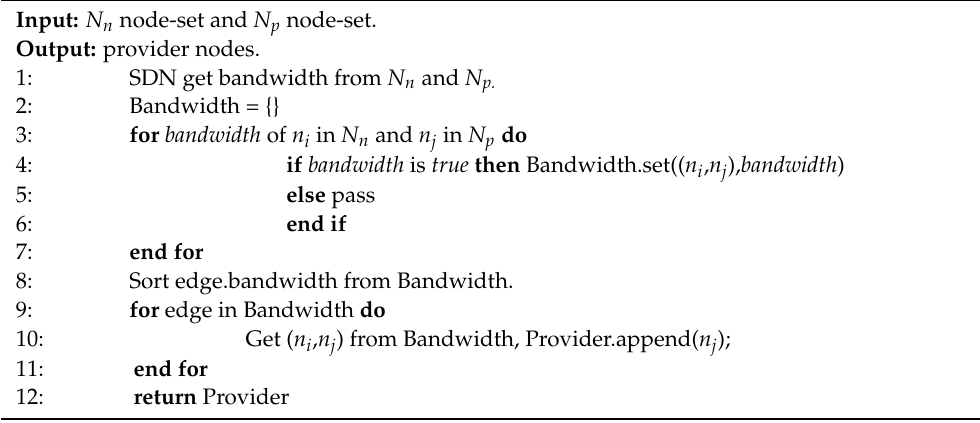
Algorithm 1 Providers node selection based on bandwidth sorting between node